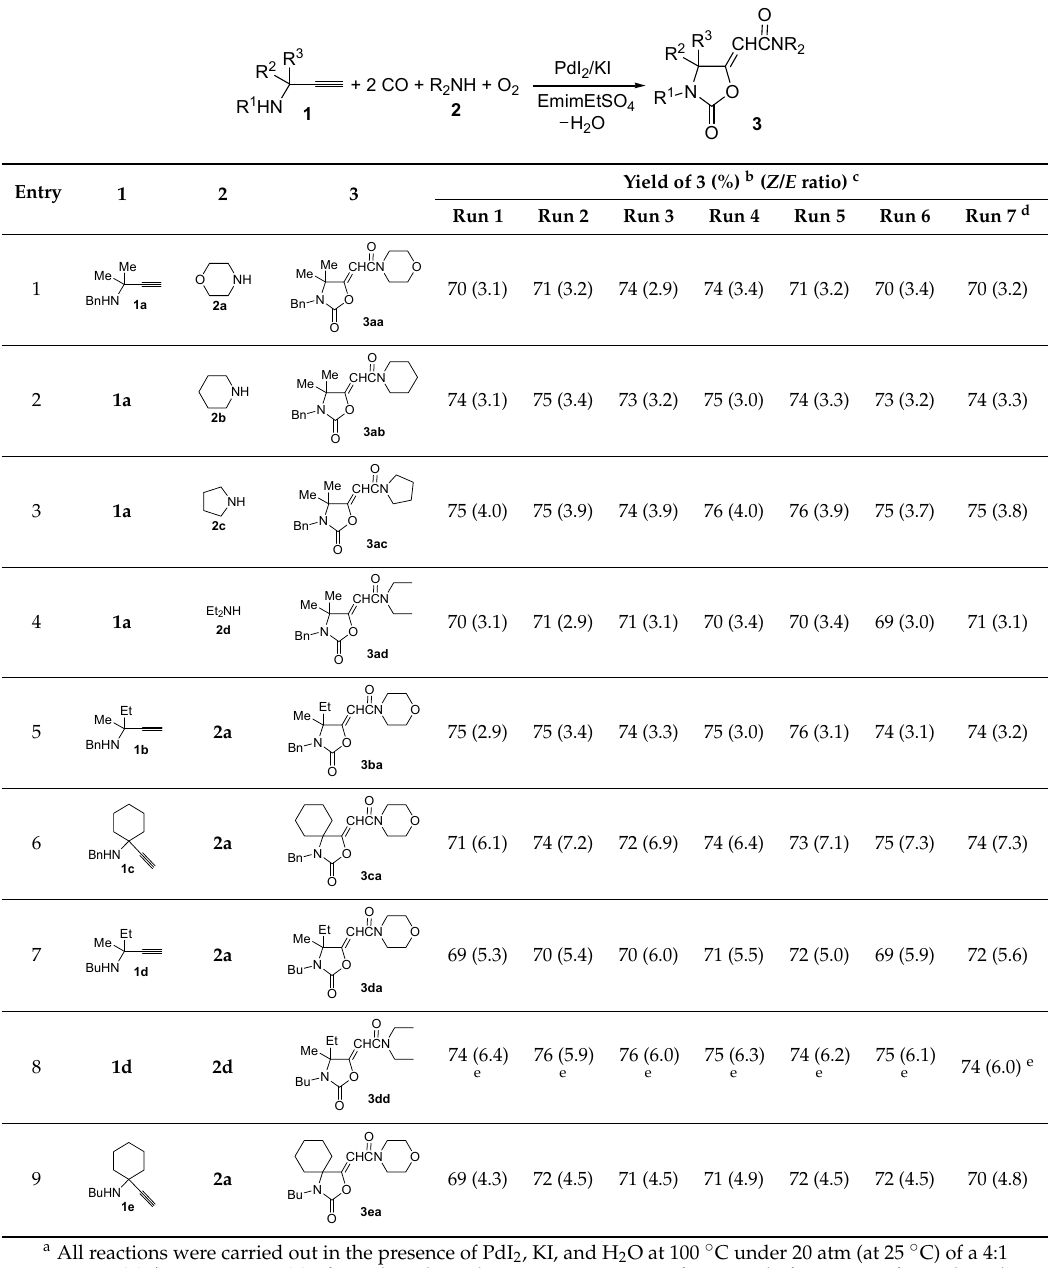
Table 1. Synthesis of 2-(2-oxooxazolidin-5-ylidene)acetamides ( 3 ) by PdI 2 /KI-catalyzed oxidative carbonylation of propargylic amines ( 1 ) with CO, O 2 , and secondary amines ( 2 ) in EmimEtSO 4 and recycling experiments a .